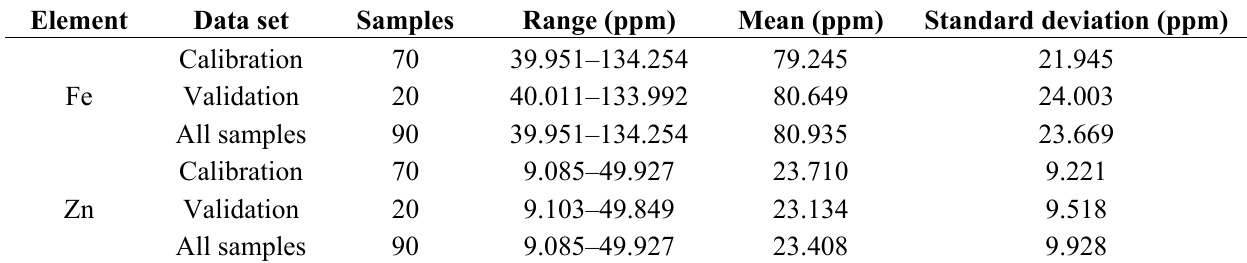
Table 1. The statistic values of Fe and Zn contents in calibration and validation